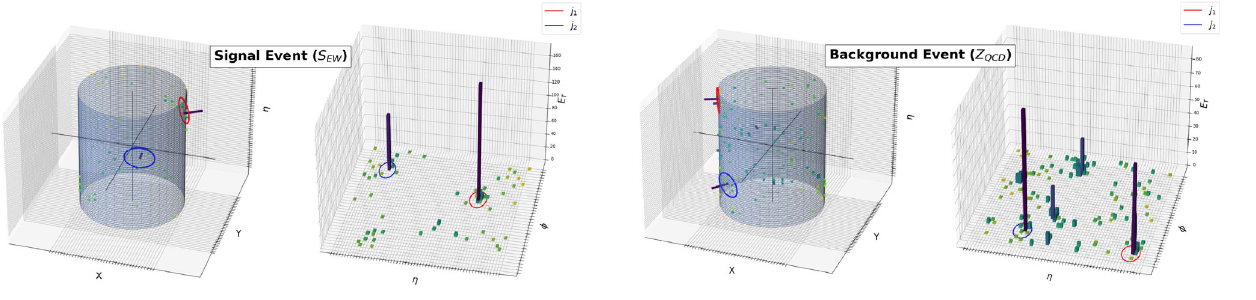
Fig. 1 The figure shows a 3D depiction of a prototype signal event originated from an electroweak VBF Higgs production in a naive detec- tor geometry in left plot. The same event is flattened in a convenient η − φ plane in right plot, where the transverse projection of calorimeter energy deposits in different pixels are drawn. Two reconstructed pri- mary jets are shown with color circles, and corresponding transverse energy deposits are visible from height of the bars